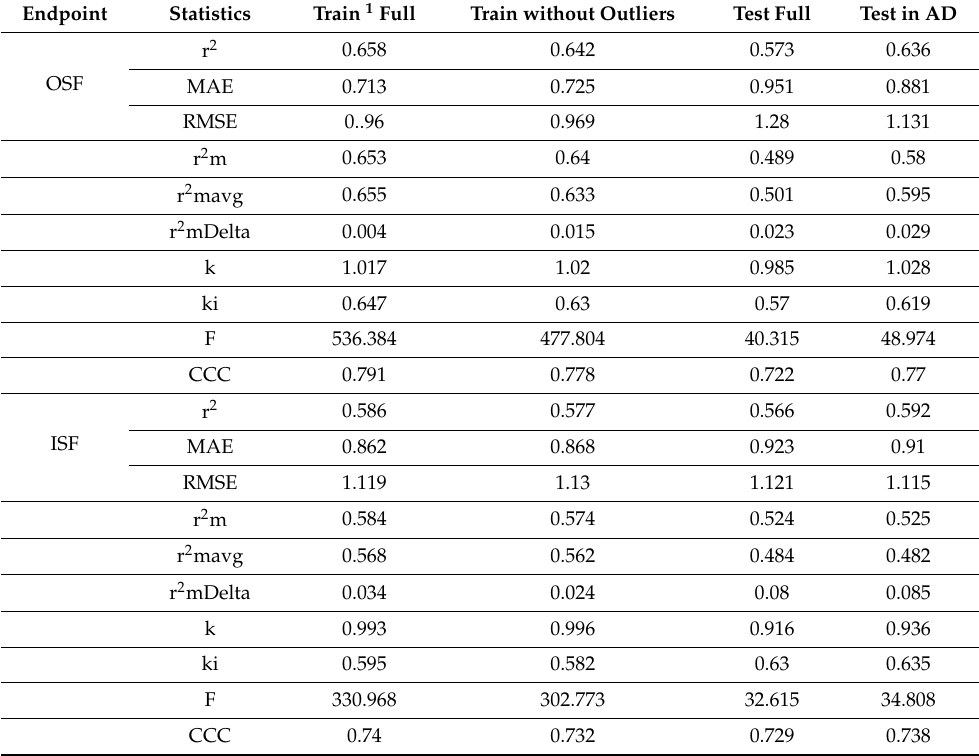
Table 4. Performance of OSF and ISF regression models after VEGA implementation. Performances are reported for the training and test sets. Since the applicability domain is evaluated with the ADI index (53), coverage is not